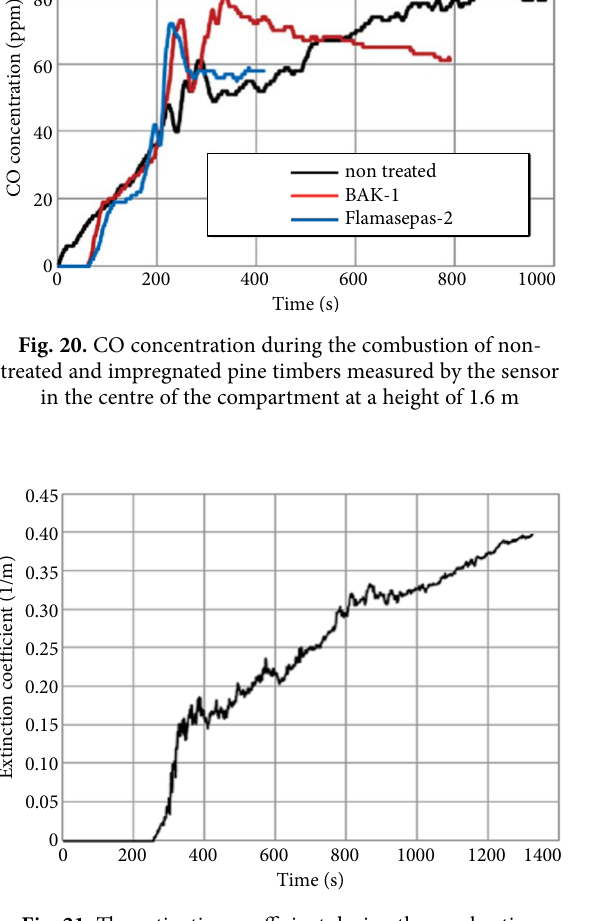
Fig. 21. The extinction coefficient during the combustion of non-treated pine timbers measured by the sensor located at a height of 1.6 m (for treated pine timbers, the extinction coefficient was equal to zero during the experiment)